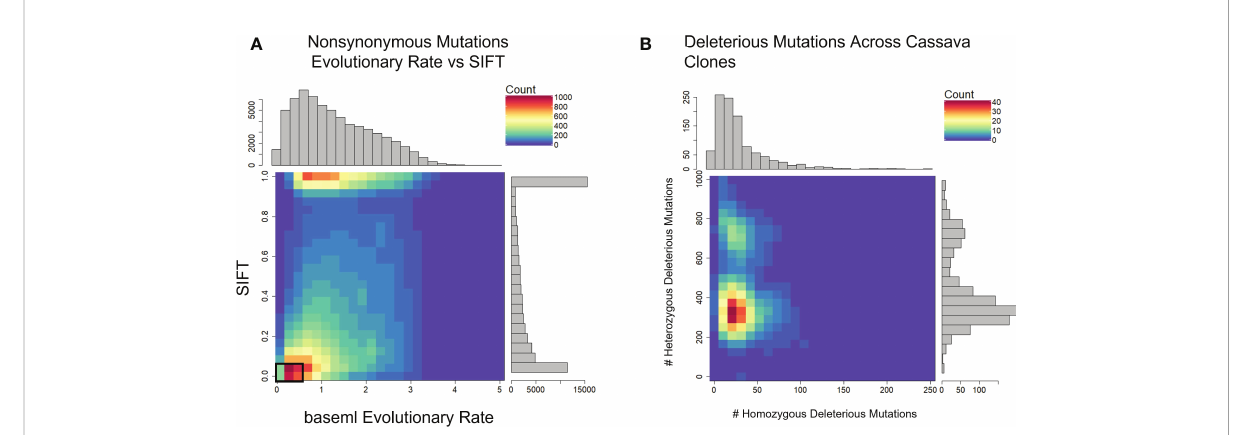
FIGURE 2 De fi ning Deleterious Mutations. (A) baseml evolutionary rate is plotted against SIFT scores. Deleterious mutations were classi fi ed as derived alleles at those sites with a baseml evolutionary rate < 0.5 and a SIFT score < 0.05 (Black box). (B) Distribution of homozygous and heterozygous deleterious mutations across 1048 cassava clones.